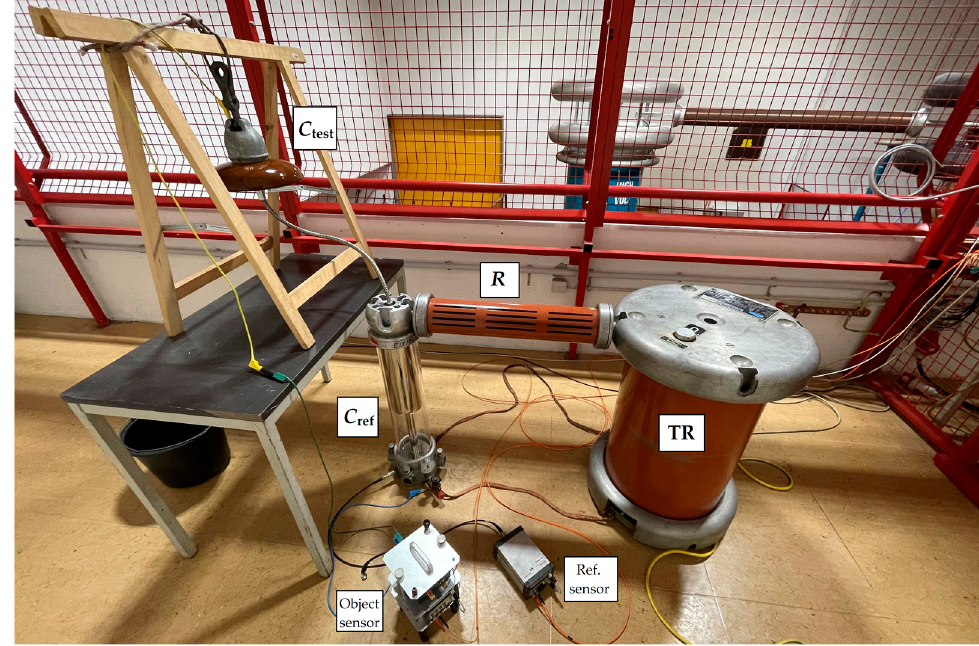
Figure 3. Measurement setup for measurement with OMICRON MI 600.